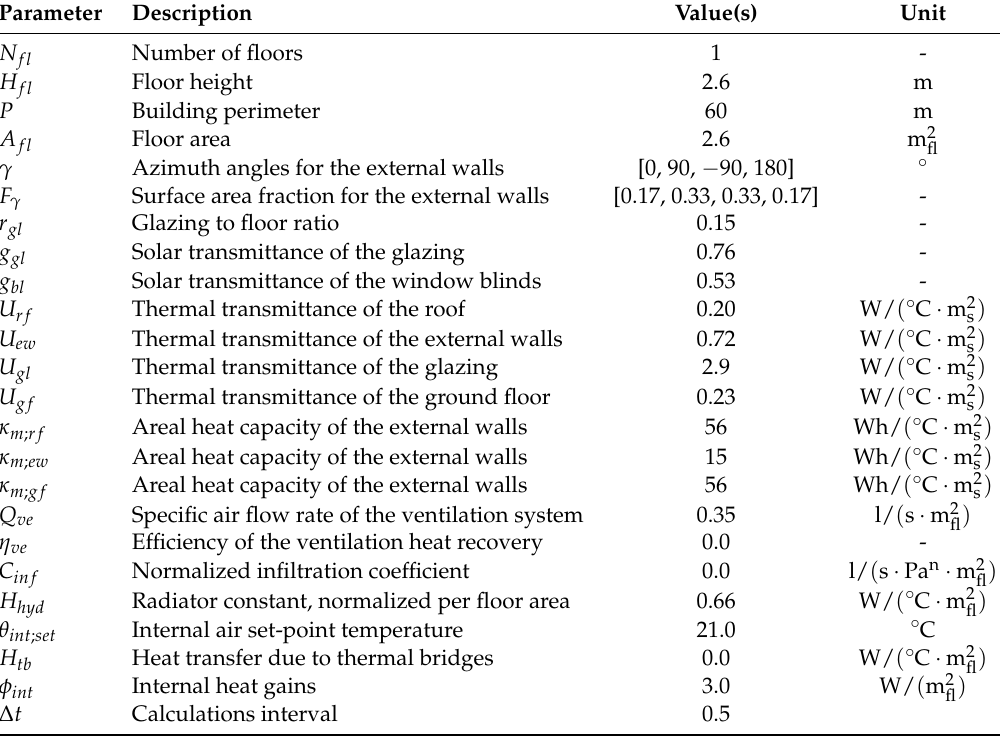
Table 5. Parameter input values used for the ISO14N model